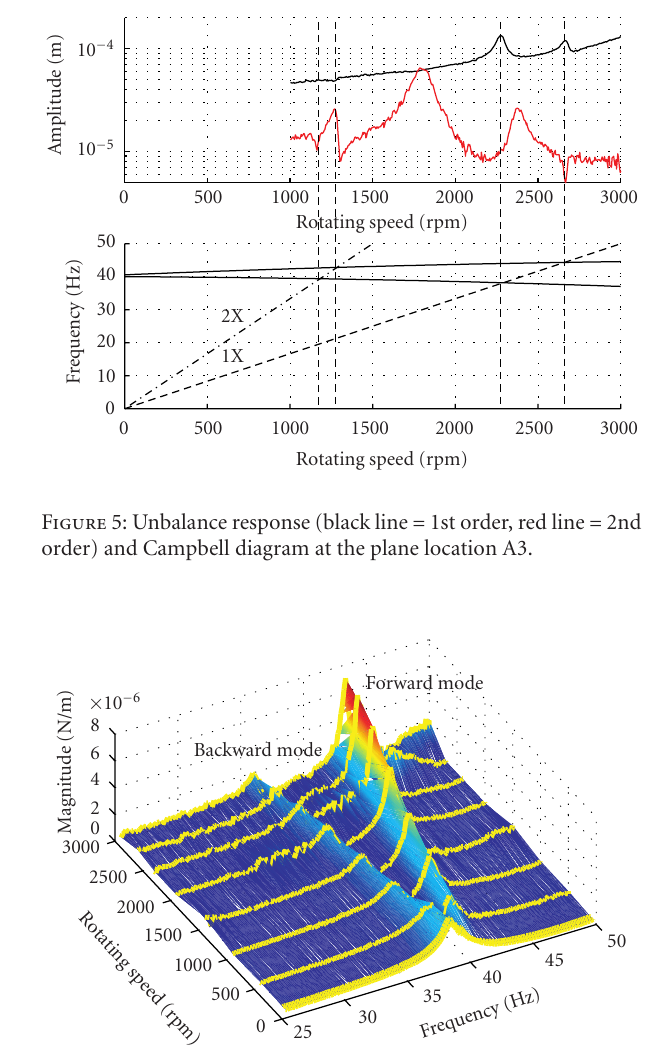
Figure 6: Waterfall of the Campbell diagram at the bearing support B1. By considering a time history record type for the unbal- ance response of rotor, the experimental orbits of the flexible rotor at each measuring plane (four planes for the proximity probe A1, A2, A3, and A4, and the two accelerometers B1 and B2) are obtained. Then, by using an interpolation to connect each measuring planes, the operational shape of the rotor is constructed. Figures 7 and 8 illustrate the orbital evolution of the flexible rotor passing through the first backward and for- ward critical speed. Figure 9 indicates the orbital evolution of the flexible rotor passing through the 2X resonance of the first forward critical speed. The internal loop (at the end of the flexible rotor) due to the combination of the asymmetry and weight of the rotor may be clearly shown. Finally, Fig- ure 10 shows the orbital evolution of the flexible rotor pass- ing through the 2X resonance of the second forward critical speed. In this case, the internal loop (at the middle of the flexible rotor) due to the combination of the asymmetry and weight of the rotor is more di ffi cult to be